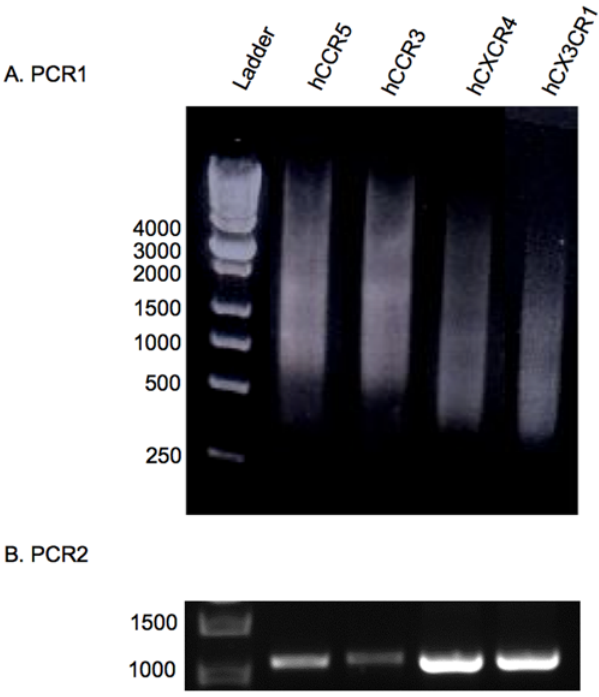
Figure 1. Analysis of PCR-based gene synthesis of human chemokine receptors. Full-length genes of hCCR5 (1,056 bp), hCCR3 (1,065 bp), hCXCR4 (1,056 bp) and hCX3CR1 (1,065 bp) were de novo synthesized using a two-step assembly/amplification PCR method and examined on 1% TAE agarose gel electrophoresis by staining with 2 m g/ ml of ethidium bromide (EB). Samples (5 m l) were mixed with 1 m l of 6 6 DNA loading buffer per lane. 1 Kb DNA ladder is also shown. A) Detection of assembly PCR (PCR1) products of each hCR. B) Detection of amplification PCR (PCR2) products of the full-length genes from PCR1.